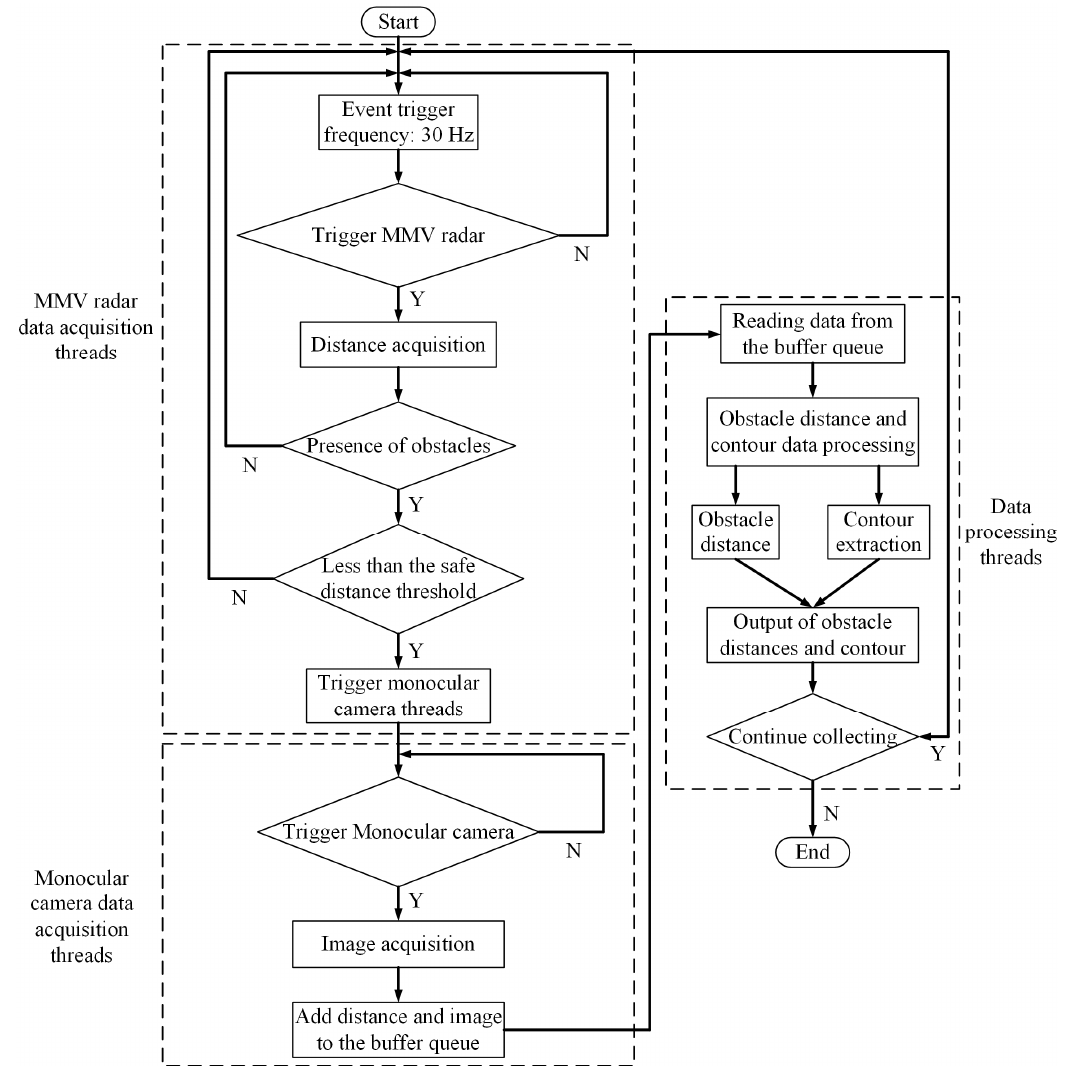
Figure 3. MMV radar and monocular camera time fusion model.